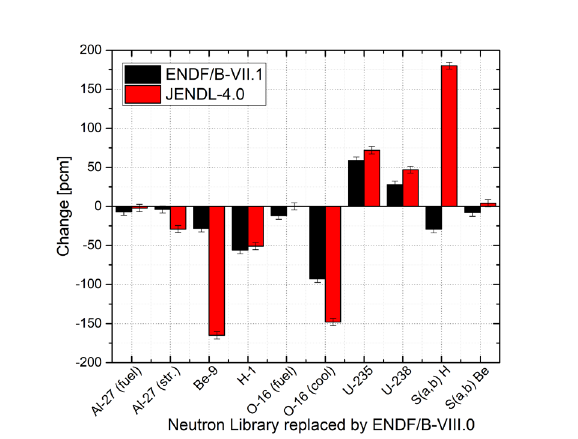
Figure 1. First criticality core configuration of RSG GAS first